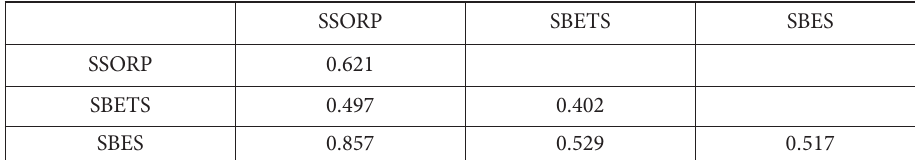
Table 4. Discriminant validity check for smart-shopper attributed behavior (three-dimensional